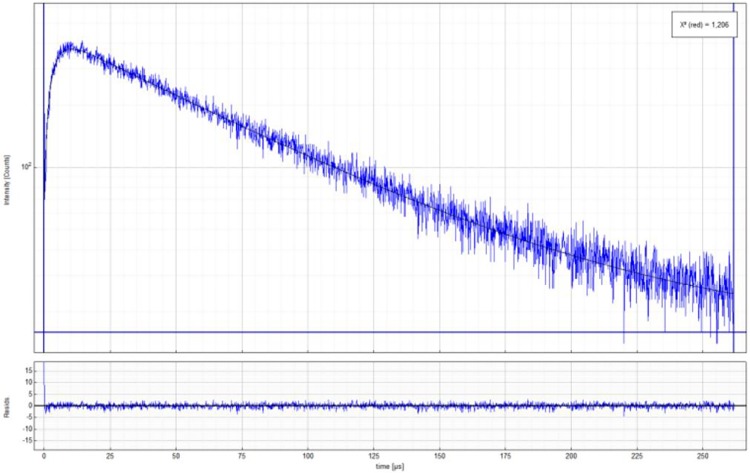
Singlet oxygen phosphorescence decay of O2(1Δg) in D2O (air equilibrated), employing Bengal Rose as sensitizer.Signal growth corresponds to dye triplet lifetime (3,4μs) and decay is excited oxygen lifetime (66μs). Lower panel shows fitting residuals.